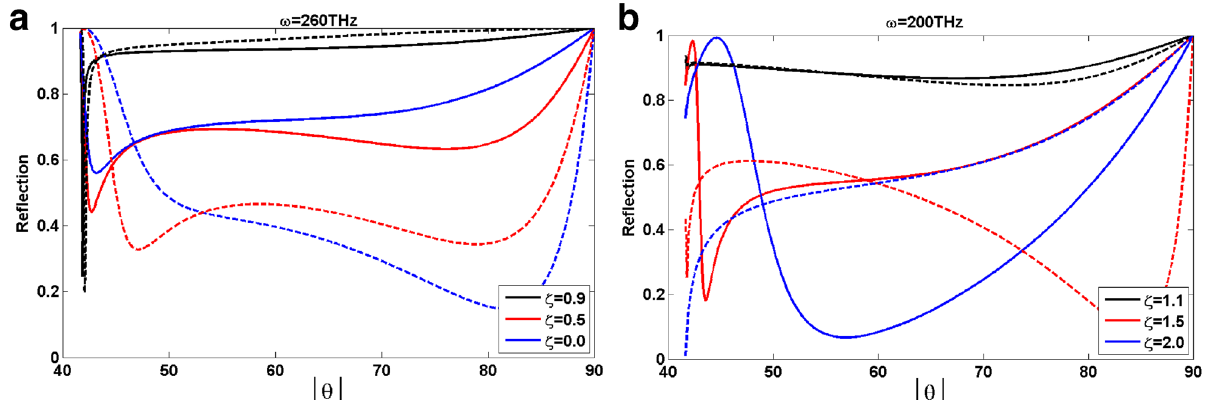
Figure 6. Reflection spectrum (R) of TM-polarized light incident on TWSM thin film in the Voigt configuration with the thickness of a in terms of the incident angle for different values of the tilt parameter. Panels ( a ), ( b ) correspond to type-I and type-II TWSMs with frequencies ω same as Fig.